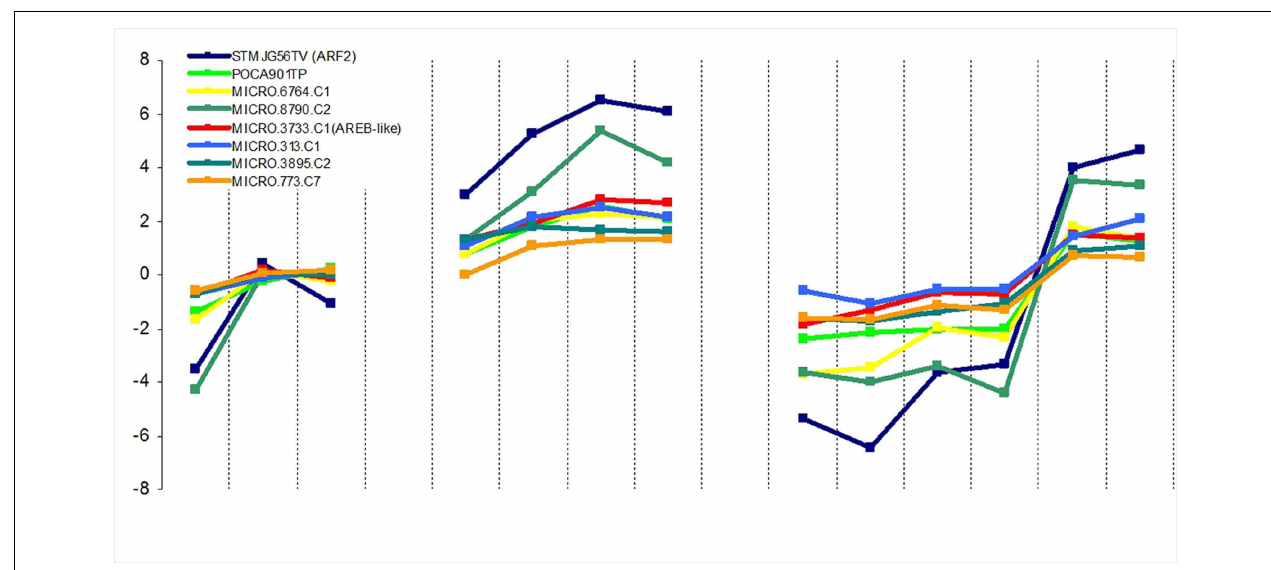
FIGURE 8 |Transcription factors positively correlating to cell wall invertase gene expression. STMJG56TV (ARF2; blue), Micro.8790.c2 (green), POCA901TP (gray), Micro.3733.c1 (AREB-like; purple), Micro.313.c1(brown) Micro.6764.c1 (yellow), Micro.3895.c1(red), and Micro.773.c7 (orange).